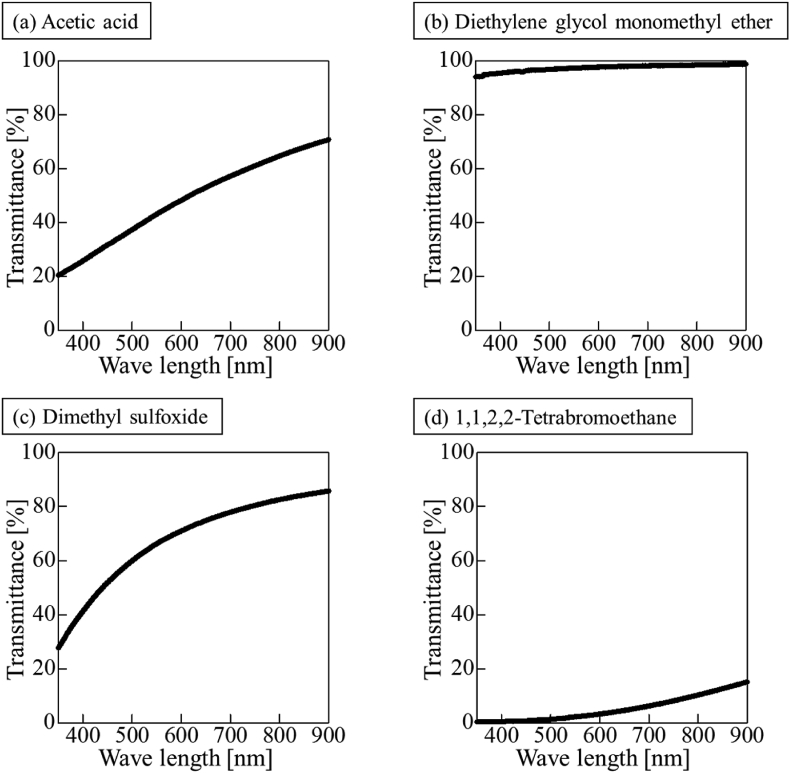
Transmittance of light in different dispersion solvents. (a)Acetic acid, (b) Diethylene glycol monomethyl ether, (c) Dimethyl sulfoxide, (d) 1,1,2,2-Tetrabromoethane.